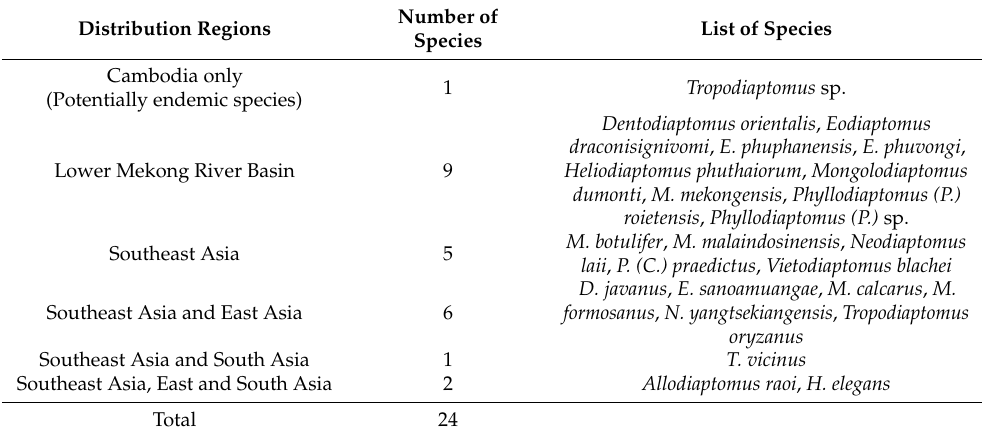
Table 5. Geographical distribution of diaptomid copepods so far recorded in Cambodia. The lower Mekong River Basin region consists of Thailand, Myanmar, Laos, Cambodia, and Vietnam. The Southeast Asian region consists of Thailand, Myanmar, Laos, Cambodia, Vietnam, Malaysia, Singapore, the Philippines, Indonesia, and Brunei. The East Asian region consists of China, Japan, North Korea, South Korea, Mongolia, and Taiwan. The South Asian region consists of India, Sri Lanka, Afghanistan, Bangladesh, Bhutan, Nepal, and Pakistan. Number of Distribution Regions List of Species Species Cambodia only 1 Tropodiaptomus sp. (Potentially endemic species) Dentodiaptomus orientalis , Eodiaptomus draconisignivomi , E. phuphanensis , E. phuvongi , Heliodiaptomus phuthaiorum , Mongolodiaptomus Lower Mekong River Basin 9 dumonti , M. mekongensis , Phyllodiaptomus (P.) roietensis , Phyllodiaptomus (P.) sp. M. botulifer , M. malaindosinensis , Neodiaptomus Southeast Asia 5 laii , P. (C.) praedictus , Vietodiaptomus blachei D. javanus , E. sanoamuangae , M. calcarus , M. formosanus , N. yangtsekiangensis , Tropodiaptomus Southeast Asia and East Asia 6 oryzanus Southeast Asia and South Asia 1 T. vicinus Southeast Asia, East and South